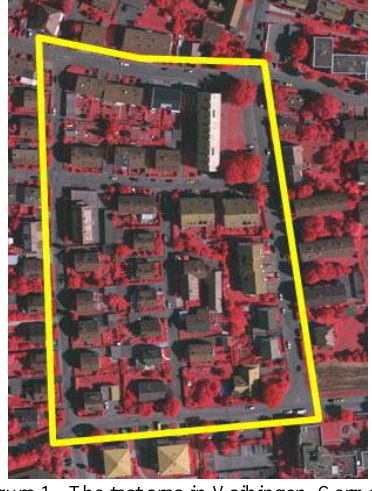
Figure 1. The test area in Vaihingen,